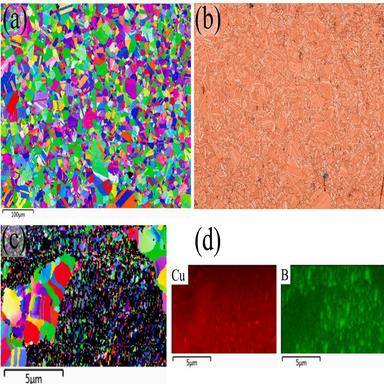
EBSD measurements of the SPS_Cu and SPS_Cu3B samples. (a) IPF map of the SPS_Cu showing random orientation of the copper grain. (b) Phase contrast map of the same area as (a). Σ3 twin boundaries are shown with white color. (c) IPF map of the SPS_Cu3B sample. Two distinct regions are visible. Two-phase structure involves very fine grain size of copper while boron-free area is distinguishable having larger grain size. (d) Distribution of copper and boron in the same area as (c). Absence of boron is visib